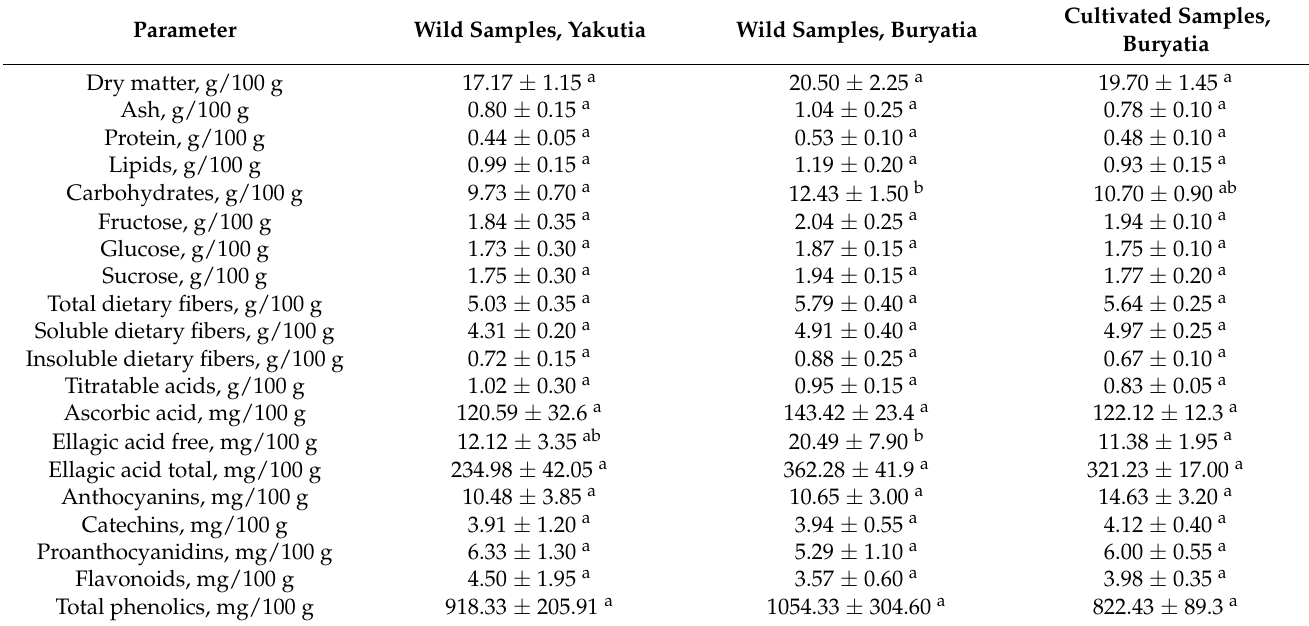
Table 1. Nutritional and chemical composition of fresh wild and cultivated F. orientalis fruits ( ±